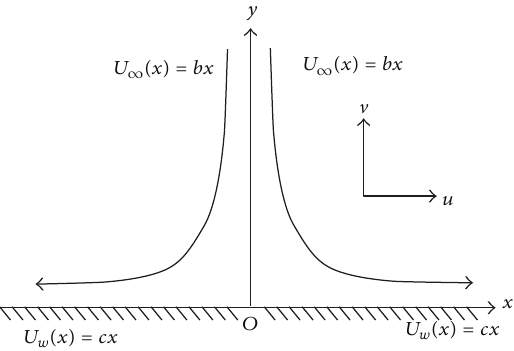
Figure 1: Schematic diagram of the